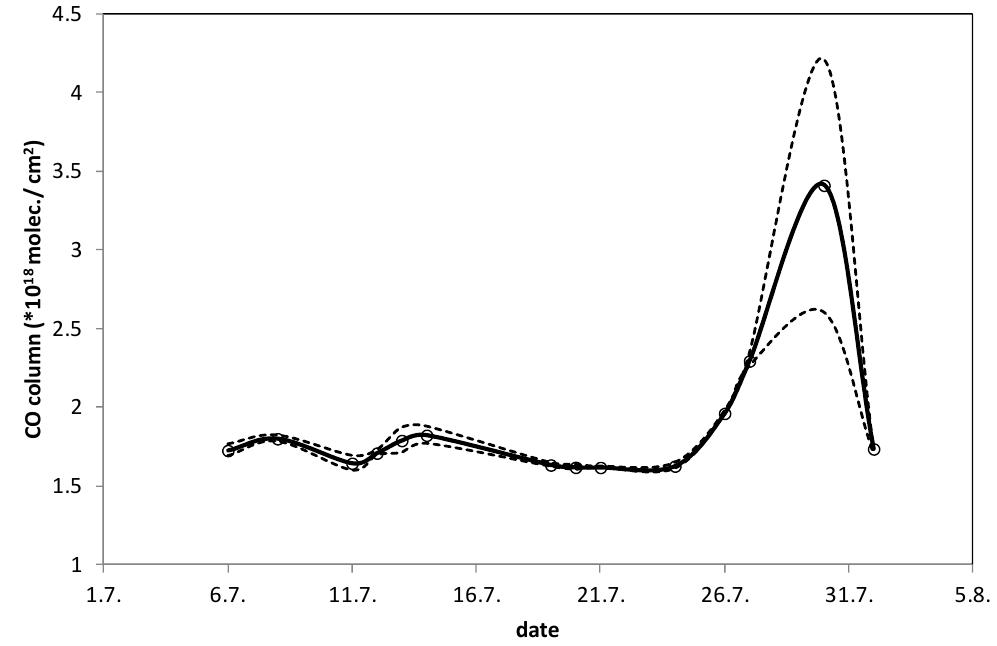
Figure 2. Daily averaged CO column abundance (thick solid line) and +/ − one standard deviation per day derived from the individual measurements (dotted lines) at Sodankylä with the FTS instrument.